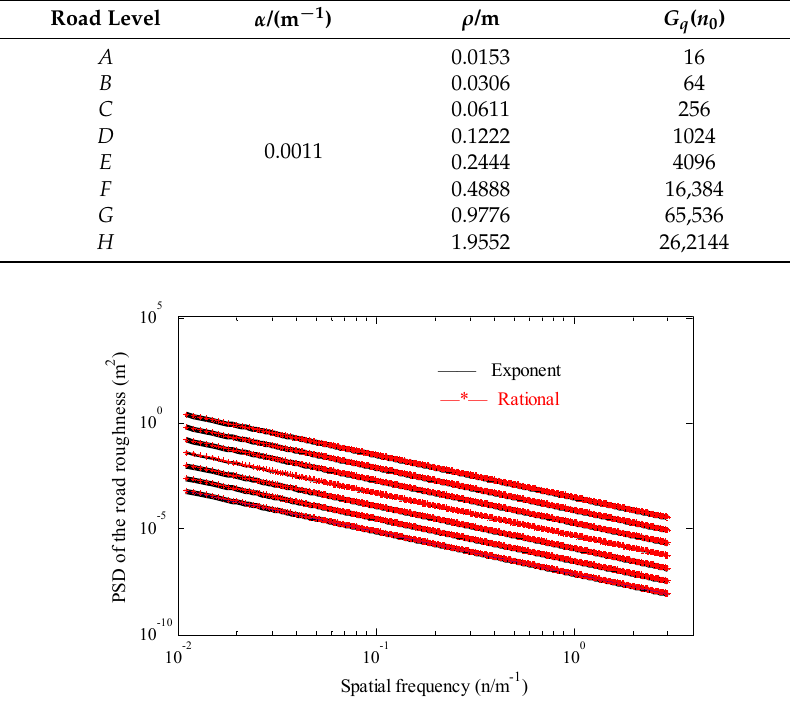
Figure 1. Results of parameters estimation.